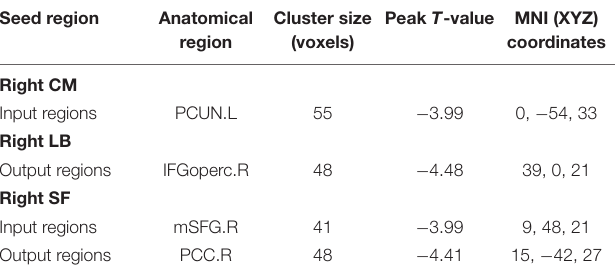
TABLE 2 | Brain regions with significant differences in right amygdala subregions seeded-EC between MDD and